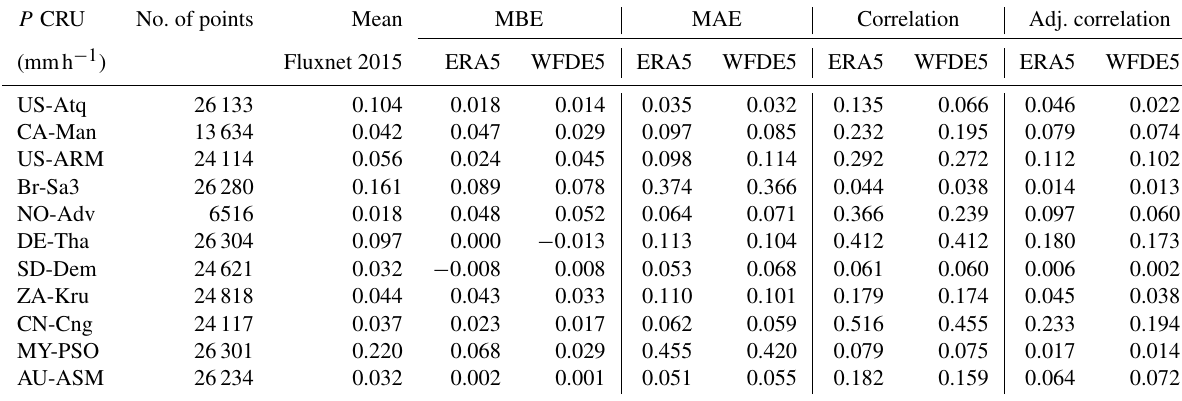
Table A7. Precipitation (Rainf + Snowf) metrics, corrected using CRU totals, for each FLUXNET2015 site: ERA5 versus FN2015 and WFDE5 versus FN2015 at hourly time steps.